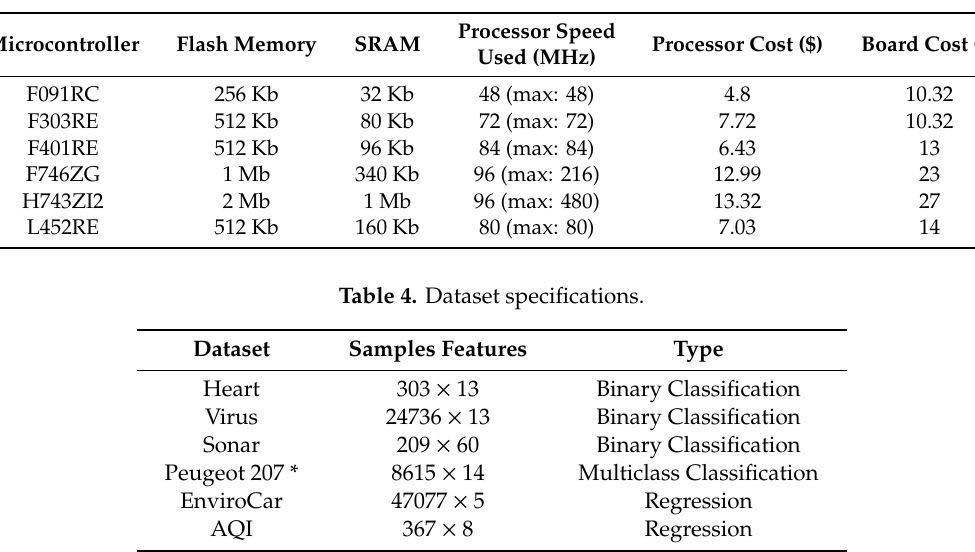
Table 3. Microcontroller specifications.